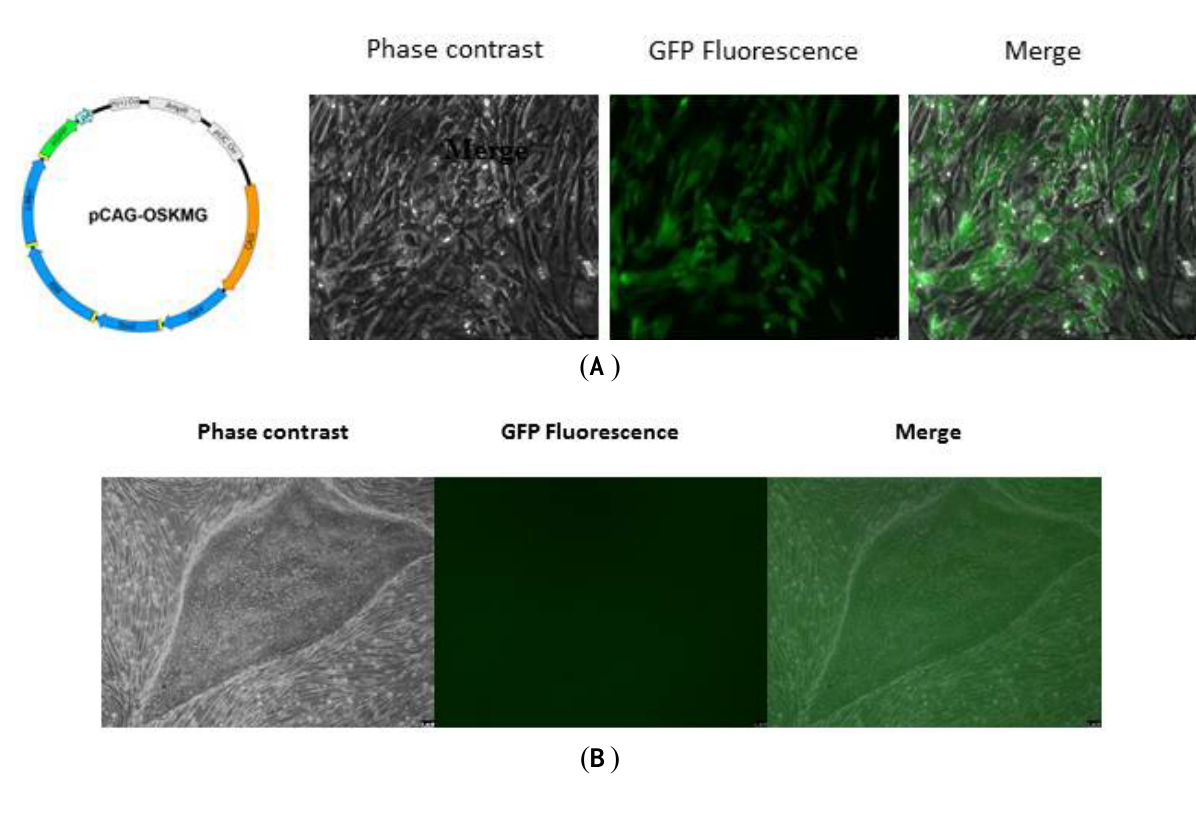
Figure 3. Retrovirus vector for induced pluripotent stem cell (iPSC) reprogramming. ( A ) Map of polycistronic retroviral vector. Human fibroblasts two days after infection with polycistronic GFP Oct4/Sox2/Klf4/cMyc; ( B ) iPSC after four weeks post infection negative for GFP indicating that the transgene is silenced in iPSC